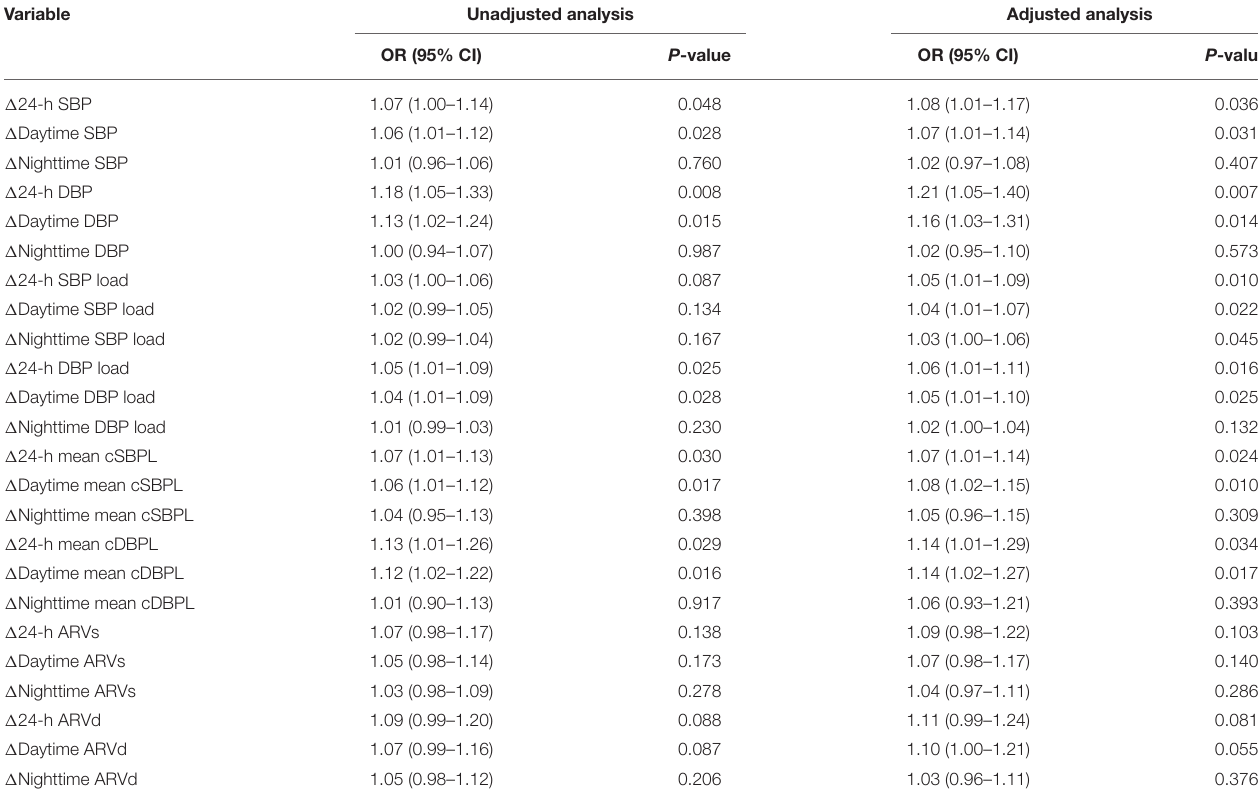
TABLE 3 | Risk factors of